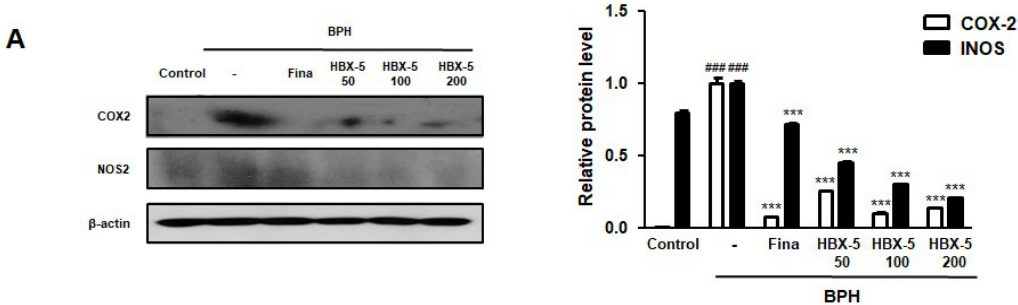
Figure 7. Effect of HBX-5 on the expression of COX-2 and iNOS in prostate tissues of rats with BPH models. ( A ) The protein levels of COX-2 and iNOS were determined by western blotting using specific antibodies. β-actin was used as an internal control. (B) Densitometric analysis was performed using ImageJ Software. The data presented as the mean ± standard error of the mean of 10 rats per group ( ### p < 0.001 vs. Control group; *** p < 0.001 vs. BPH group). Control, Control group; BPH, rats with BPH group; Fina, rats with BPH group treated with 5 mg/kg/day of finasteride; HBX-5 50, rats with BPH group treated with 50 mg/kg/day of HBX-5; HBX-5 100, rats with BPH group treated with 100 mg/kg/day of HBX-5; HBX-5 200, rats with BPH group treated with 200 mg/kg/day of HBX-5.